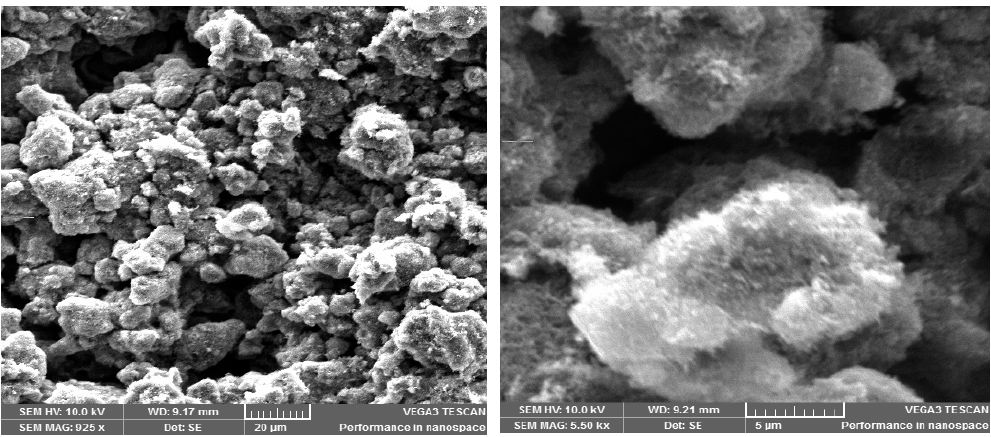
Figure 1. SEM images of CNTs.